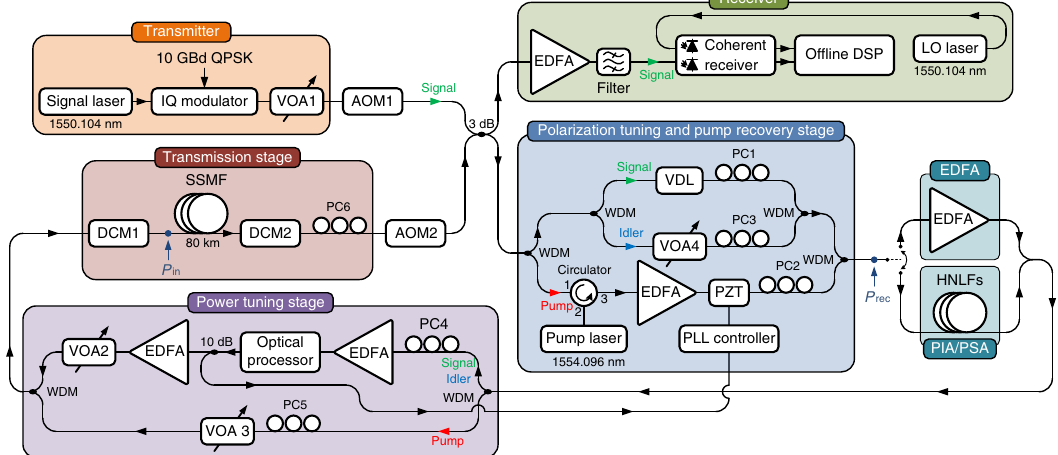
Fig. 2 Experimental set-up. Recirculating loop set-up used to demonstrate long-haul transmission with in-line PSA-based ampli fi cation. Option with in-line EDFA- and PIA-based ampli fi cation used for benchmarking is also shown. Colored arrows indicating waves represent PSA case for the second and the following round trips. IQ modulator in phase/quadrature modulator, AOM acousto-optic modulator, VDL variable delay line, PC polarization controller, HNLF highly nonlinear fi ber, PLL phase-locked loop, DSP digital signal processing, LO local